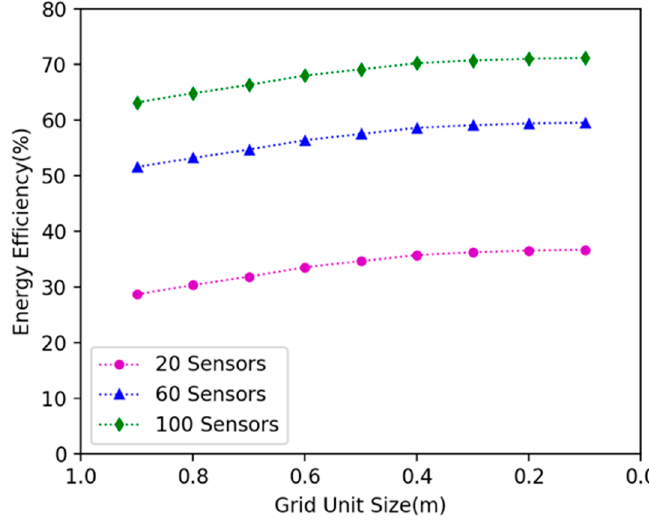
Figure 10. The e ff ect of di ff erent grid sizes on the energy e ffi Figure 10. The effect of different grid sizes on the energy efficiency.